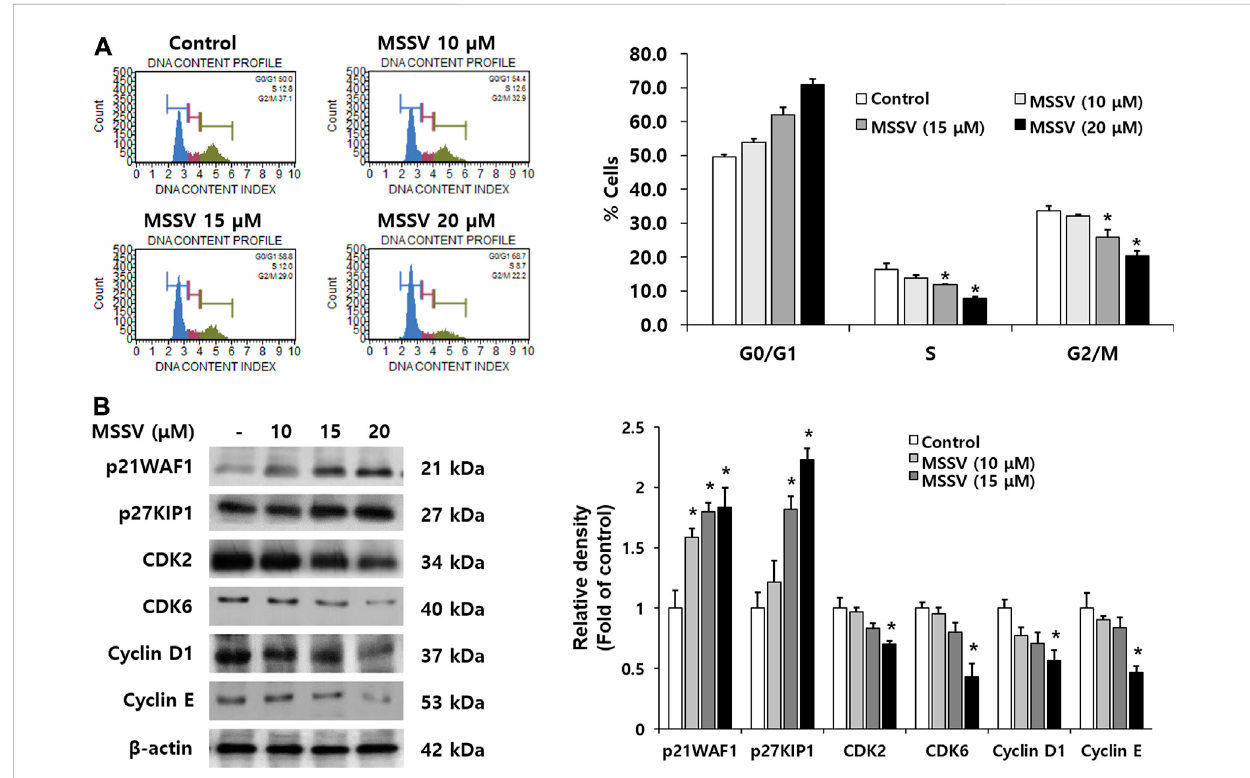
FIGURE 3 MSSV induces G0/G1 phase arrest in HCT116 cells (A) The effect of MSSV on cell cycle progression in HCT116 cells was estimated using the Muse ® Cell Analyzer. Cells weretreated with MSSV atconcentrations of 10,15, and 20 μ M. MSSV caused G0/G1 phase arrest in HCT116 cells. The bar represents the percentage of cells in each cell cycle phase. (B) The expression levels of proteins related to checkpoint control at G0/G1 phase in the presence or absenceofMSSVwereexaminedbyimmunoblotting.TheexpressionlevelofproteinsincellswasaffectedbythetreatmentwithMSSV(0,10,15,and 20 μ M).ThebarrepresentstherelativefoldchangesinproteinsatdifferentconcentrationsofMSSVincomparisonwiththecontrol.Dataarepresentedas mean ± SD and the * (asterisk) indicated statistically signi fi cant difference. A p -value of < 0.05 was considered statistically signi fi